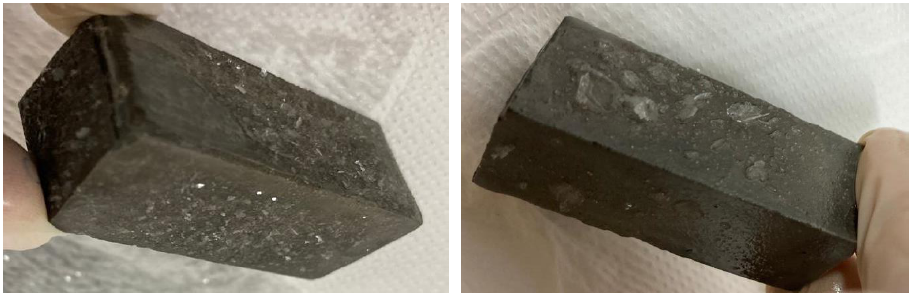
Figure 12. Photographs of products formed on TS surfaces after deposition for 120 days at 40 °C in 1 mol/L solutions, on the left TS deposited in nitrate solution, on the right in hydroxide.